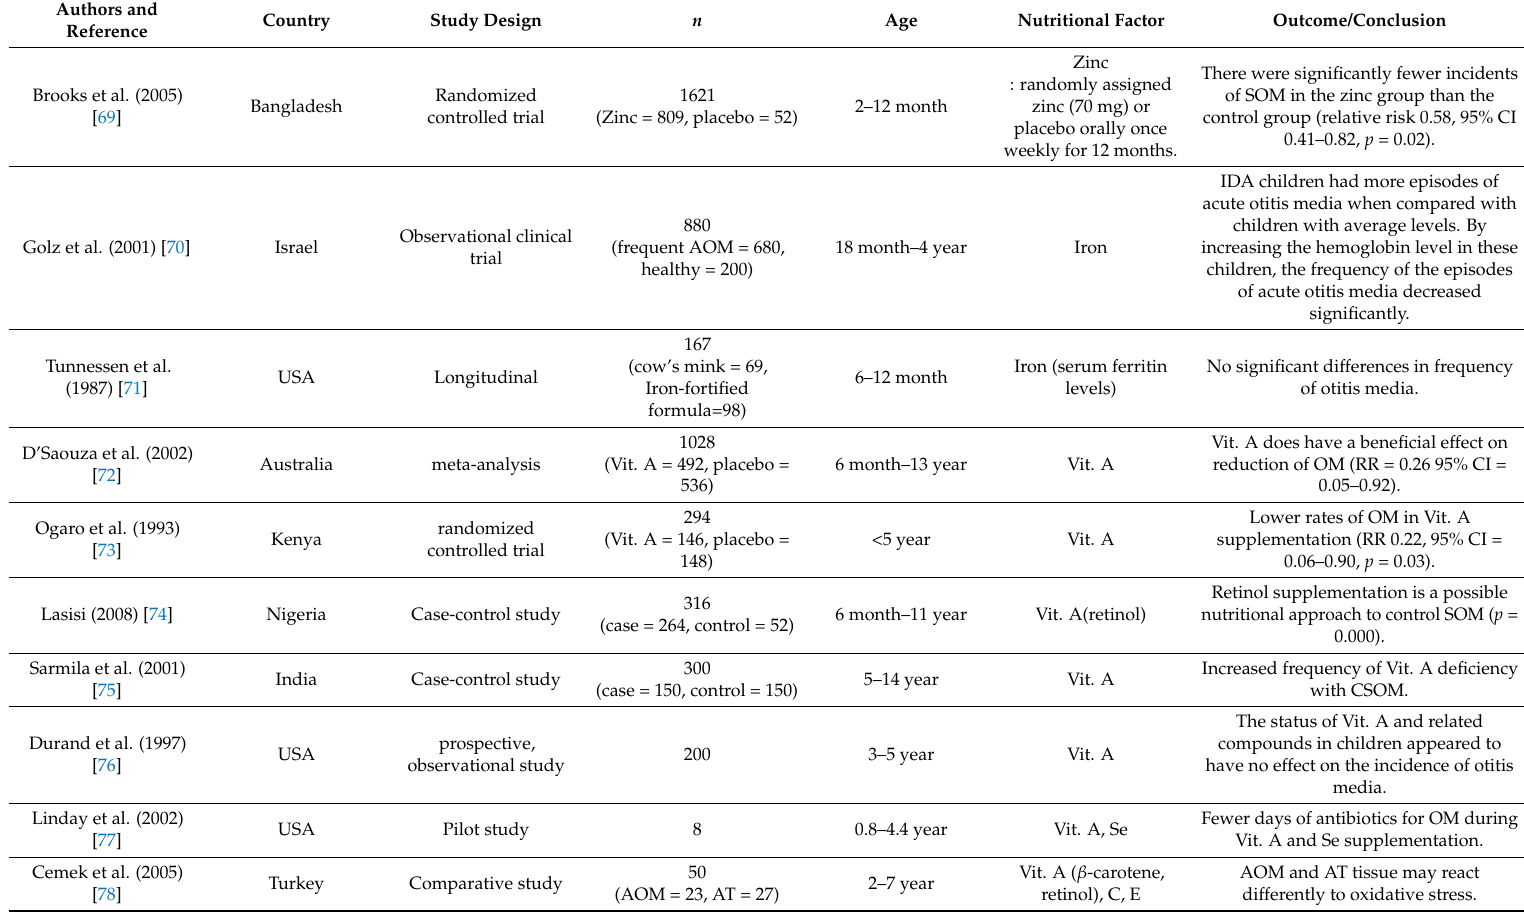
Table 4. Studies assessing the association between pediatric middle ear infection and